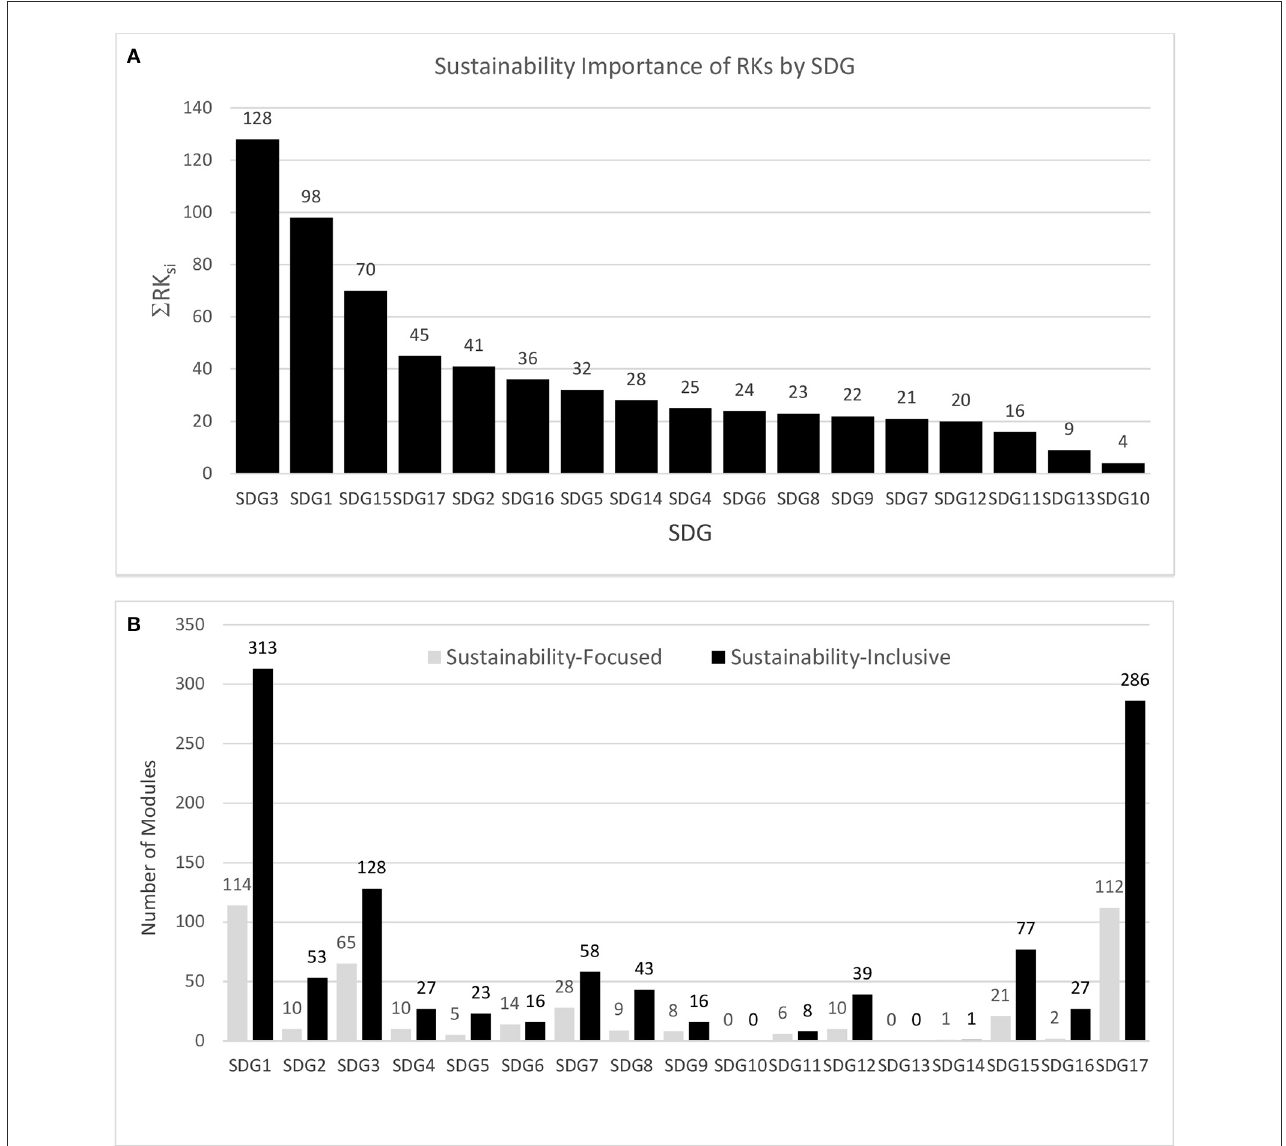
FIGURE1 Summary of results from the computational technique used to evaluate the embeddedness of sustainability in TU Dublin modules/courses. (A) Sum of the 6 RK SI values for RKs associated to each SDG, applying the filter. (B) TU Dublin modules/courses mapped to each of the